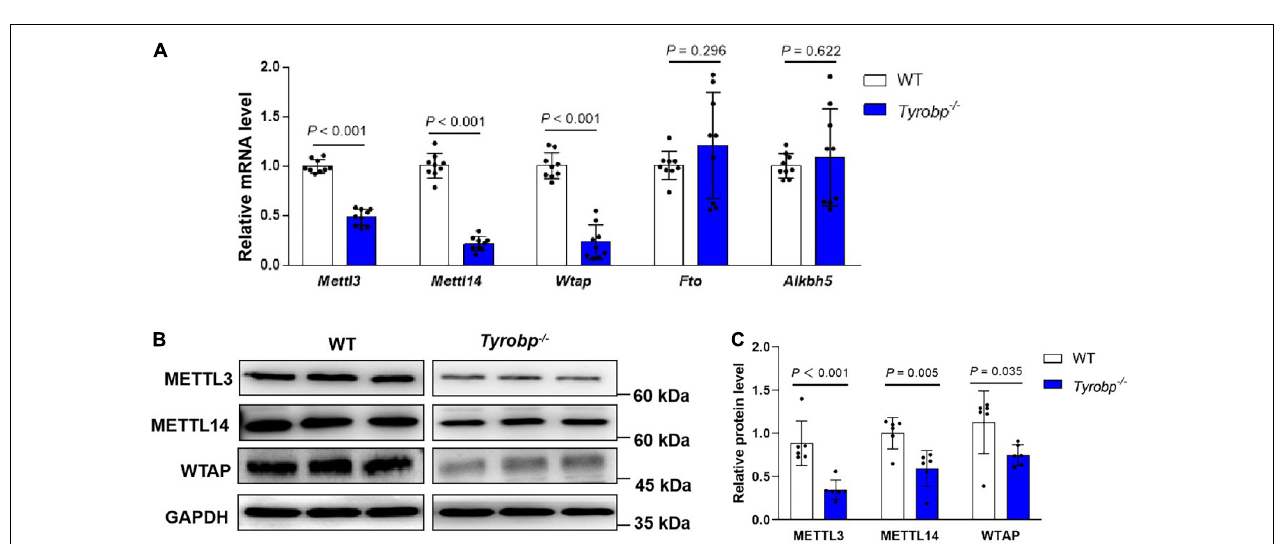
FIGURE 5 | Reduced m6A RNA methyltransferases in the hippocampus of Tyrobp − / − mice. (A) Relative levels of Mettl3 , Mettl14 , and Wtap mRNAs encoding methyltransferases and of Fto and Alkbh5 mRNAs encoding demethylases. (B,C) Western blotting and quantification of METTL3, METTL14 and WTAP in the hippocampus. Data are mean ± SEM (six or nine mice per group). Differences were assessed for significance using Student’s t test.